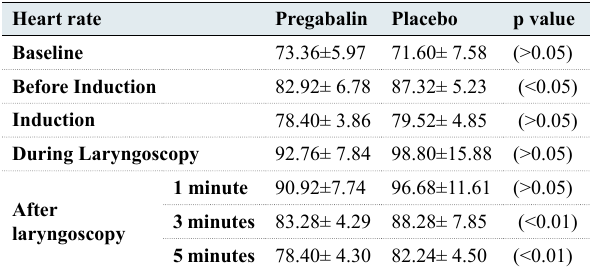
Table 2: Comparison of Heart rate ( Mean) in two groups